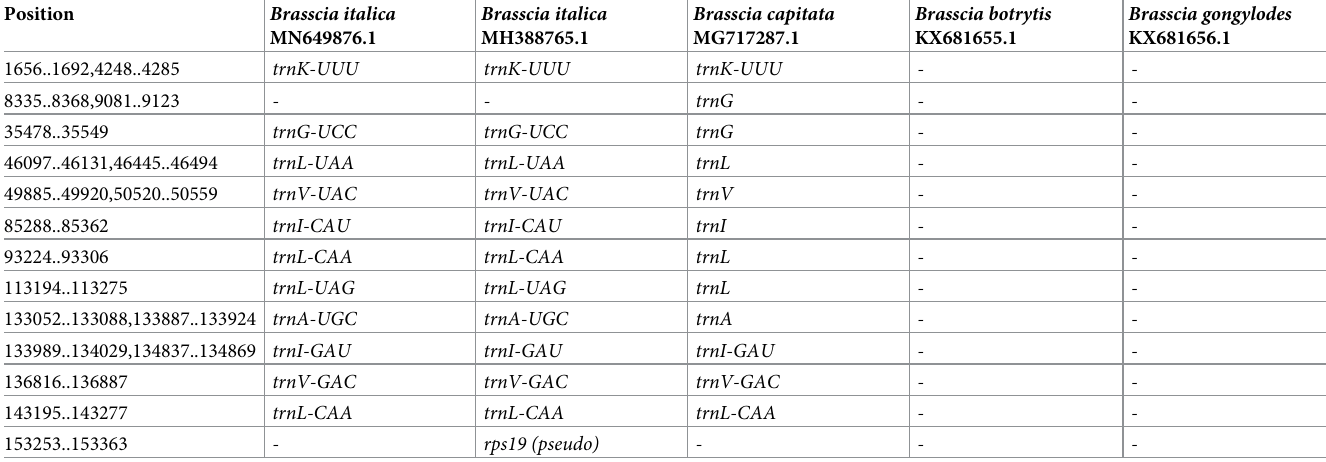
Table 4. Differences in annotated genes between the newly generated genome (MN649876.1) and other Brassica oleracea genomes. Position Brasscia italica